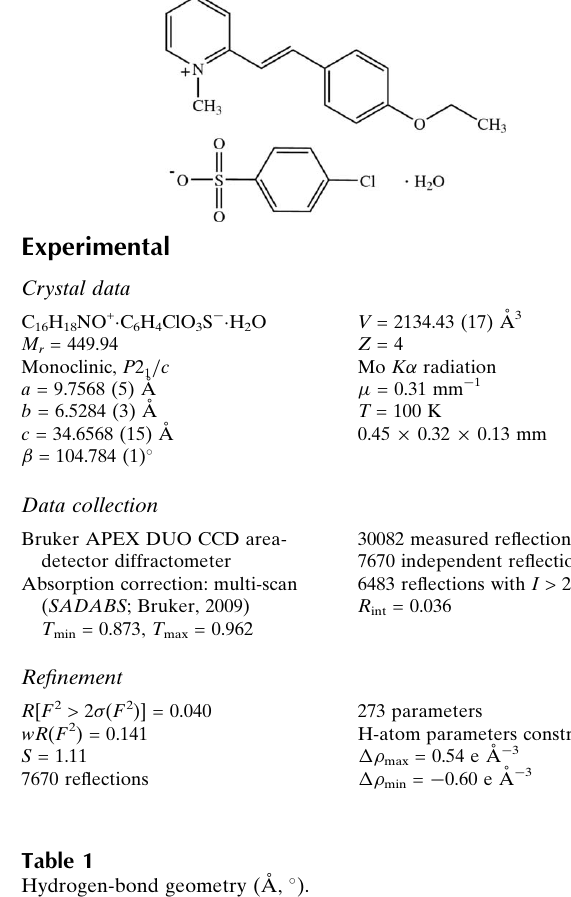
Hydrogen-bond geometry (A˚ , (cid:4)